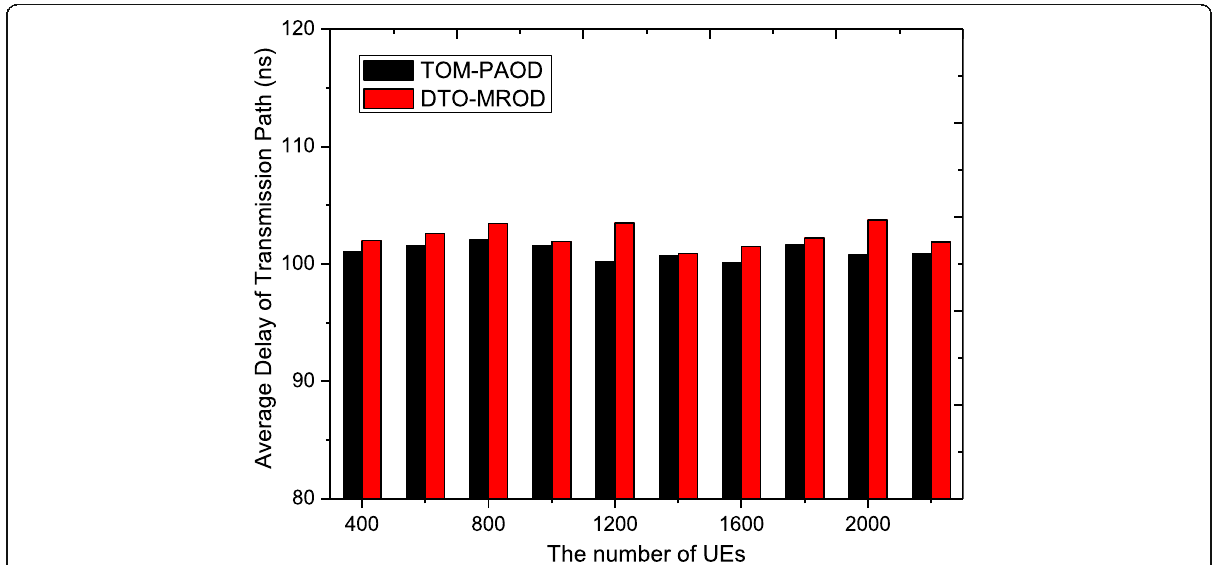
Fig. 4 Delay performance comparison: variation trend of delay in the two schemes with the number of UEs in the given